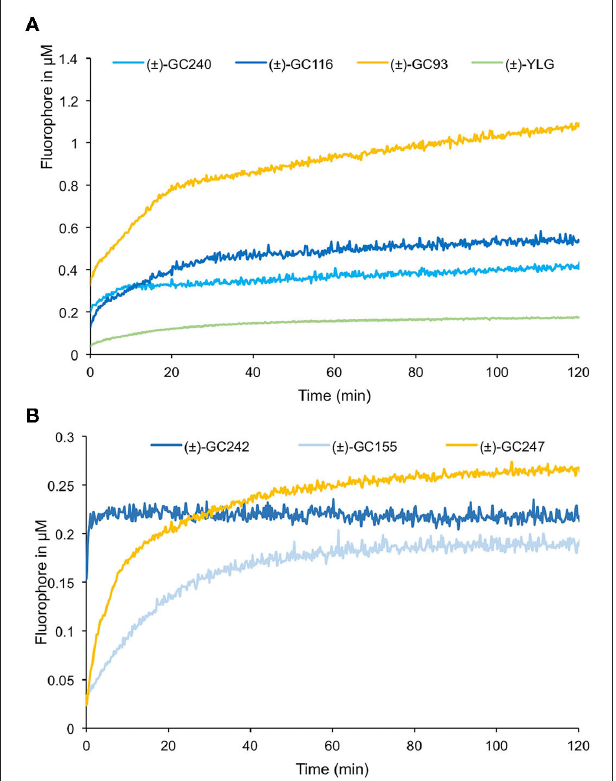
FIGURE 9 | Enzymatic assays with profluorescent probes harboring various fluorophores. Progress curves profluorescent probes at 10 µ M cleavage harboring D-ring with one methyl (A) or two methyl groups (B) , with RMS3 protein at 400nM monitored ( λ em : 460nm) at 25 ◦ C. These traces represent one of the three replicates, and the experiments were repeated at least two